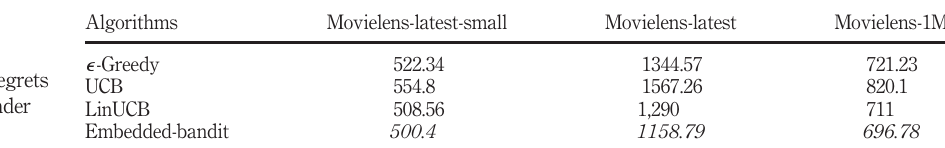
for recommender system